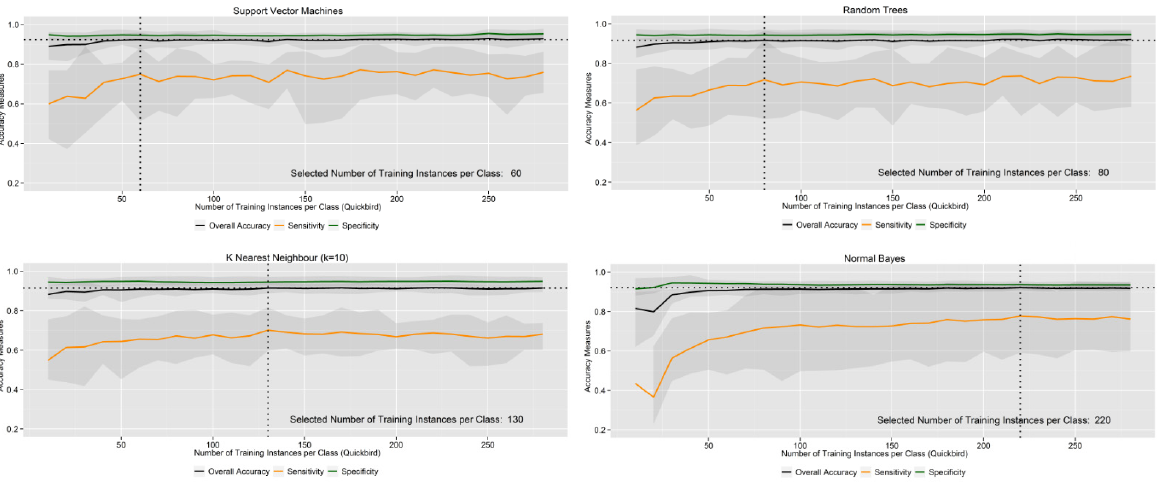
Figure 8. Influence of the training set size on the classification accuracy for QB. Mean and range of accuracy measures from the ten-fold cross-validation are shown for each iteration.